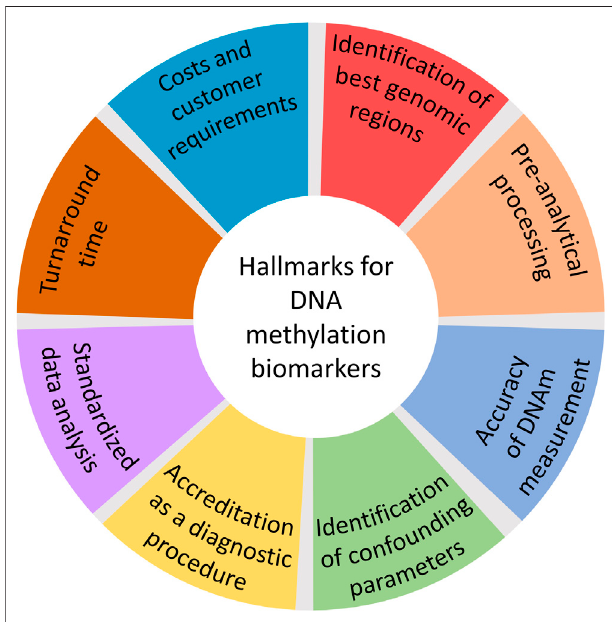
FIGURE 1 | Aspects to be considered when designing diagnostic epigenetic biomarkers.